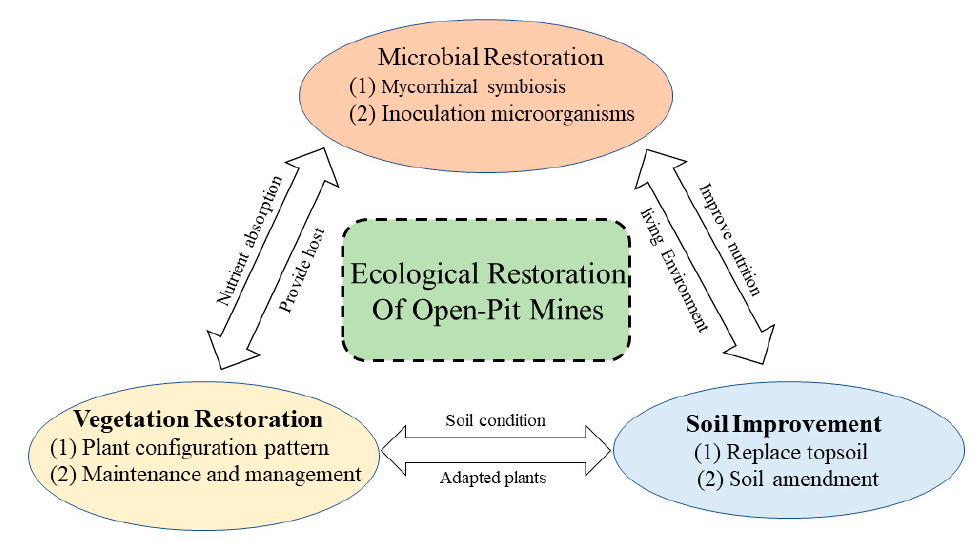
Figure 3. Interrelationship of mine ecological restoration